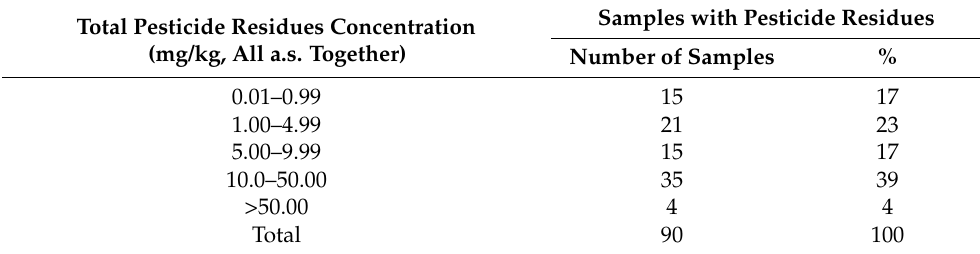
Table 1. Pesticide residue levels in 90 samples of cut flowers sampled in Belgium (2016).